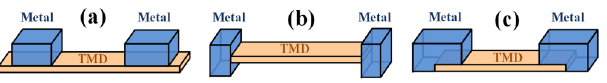
FIG. 3. Schematic of metal-mTMD (a) top contact, (b) edge contact, and (c) combined